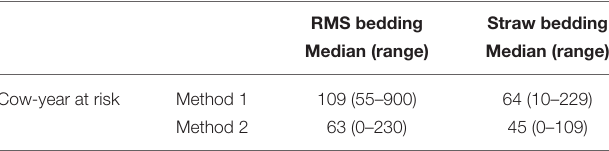
TABLE 4 | Variation of the number of cows-year at risk in the two groups (26 RMS farms and 60 straw farms) when using different follow-up